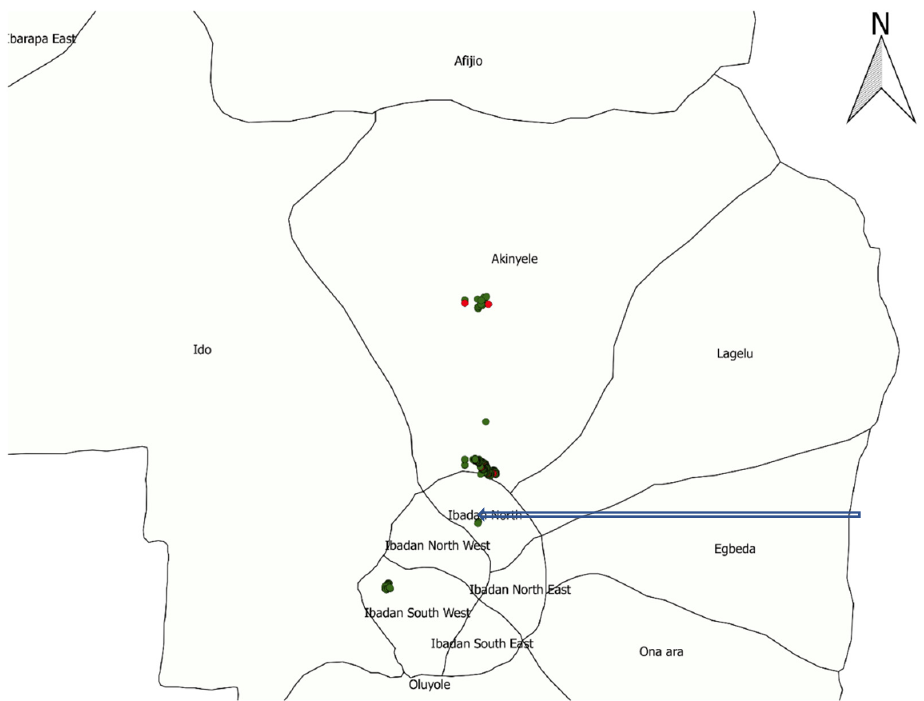
Figure 2. Samples collection points across the three Local Government Areas covered in Ibadan Metropolitan area, Oyo State. Dots represent Echinococcus granulosus positive (red) and negative (green) results. The arrow indicates the position of the abattoir.